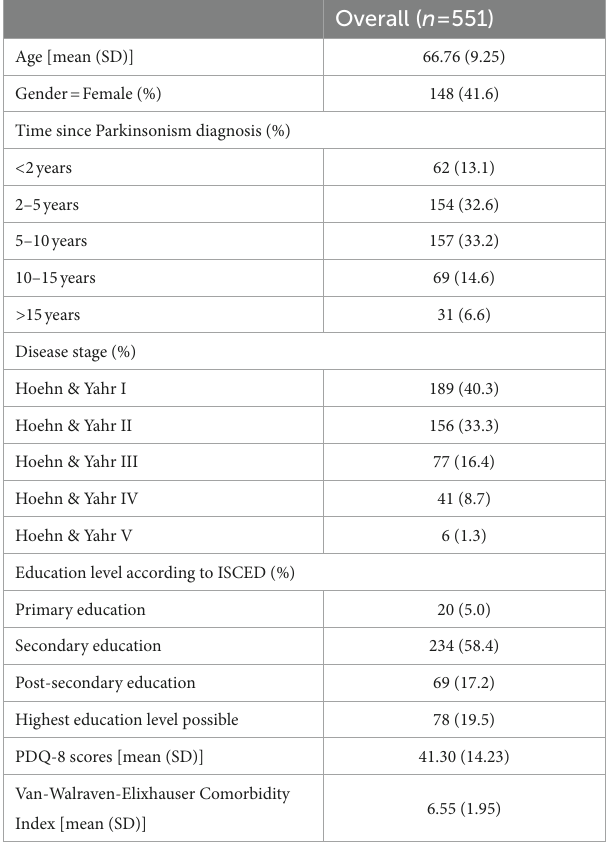
TABLE 1 Demographics and clinical characteristics of survey